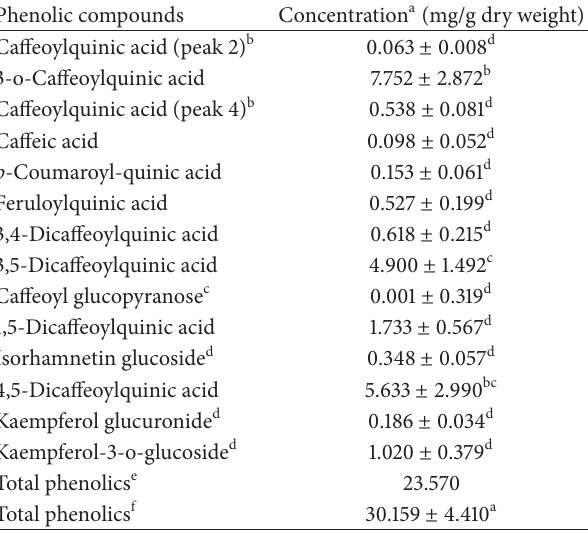
Table 2: Concentration of total phenolics and phenolic compounds in H. tuberosus leaves (cv.